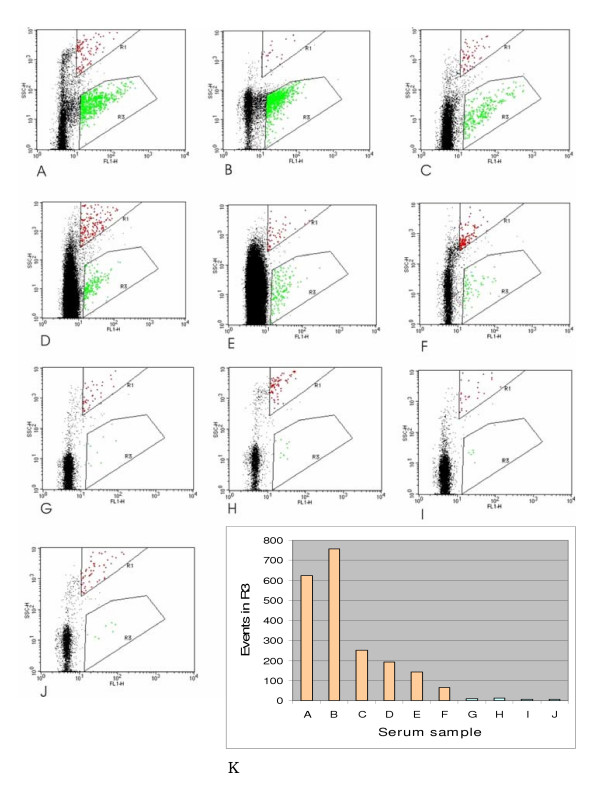
Analysis of serum from BSE-positive cattle. FITC-labeled recombinant prion protein (10 nM) was incubated in 150 μl of the serum samples as described in the methods section and analyzed by flow cytometry. The measurements are shown in a Fluorescence 1 (FL1-H) vs. Side-Scatter (SSC) dot-plot. All six BSE-samples (A-F) can be differentiated from the controls (G-J) by a population of events in region R3 (green dots). Panel K: Quantification of measurements shown in panels A-J.